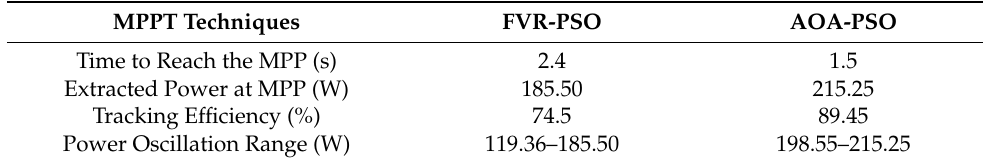
Table 3. Comparative study between FVR-PSO MPPT and AOA-PSO MPPT.